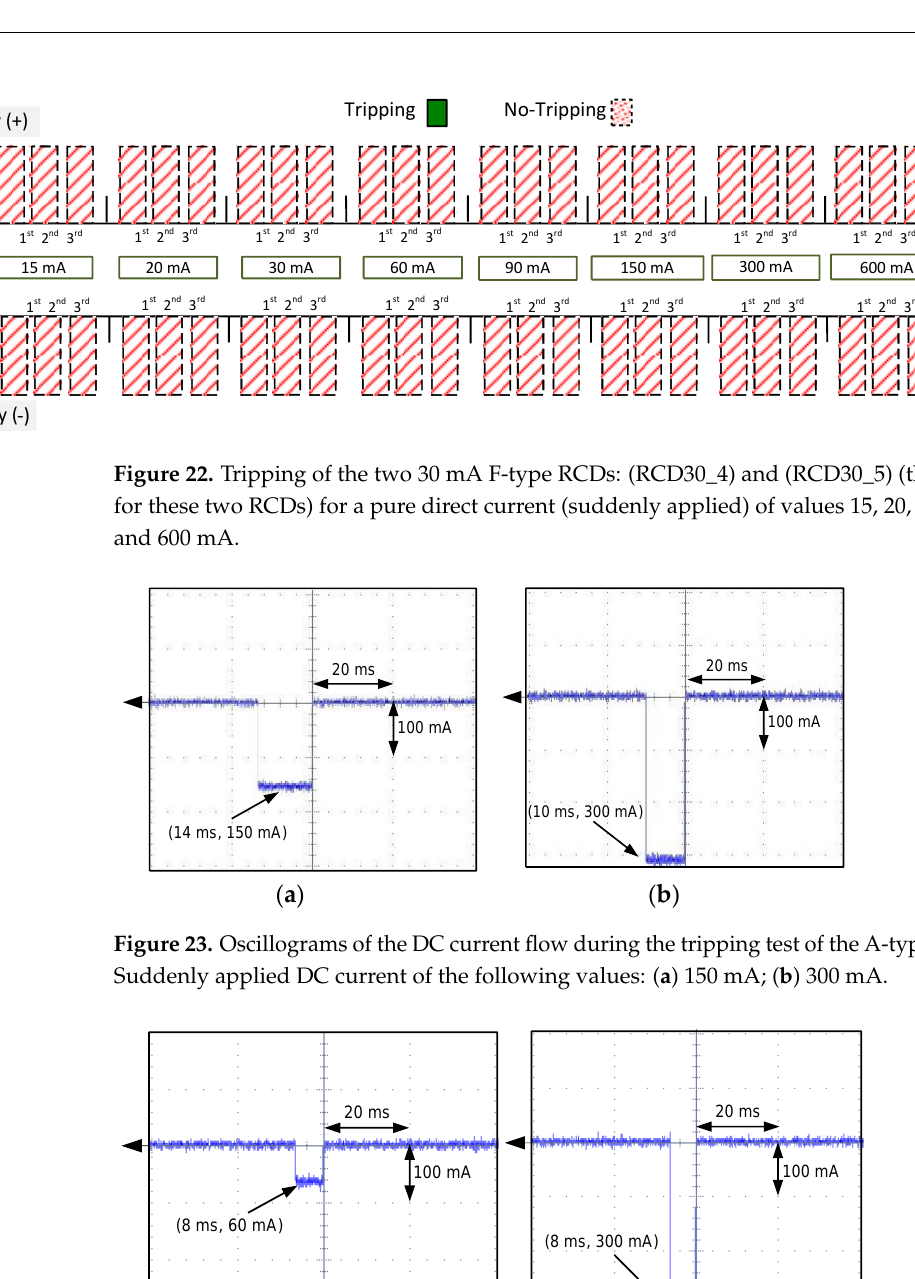
Figure 25. Oscillograms of the DC current flow during the tripping test of the A-type RCD (RCD30_1). Suddenly applied DC current of the following values: ( a ) 30 mA; ( b ) 300 mA.